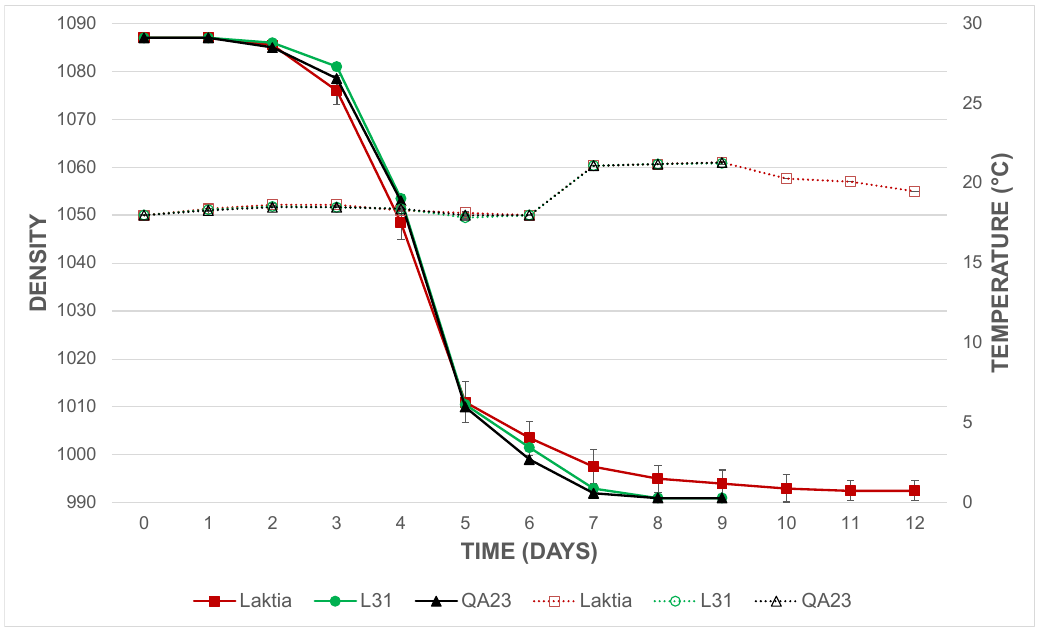
Figure 1. Comparative evolution of density and temperature during must fermentation.